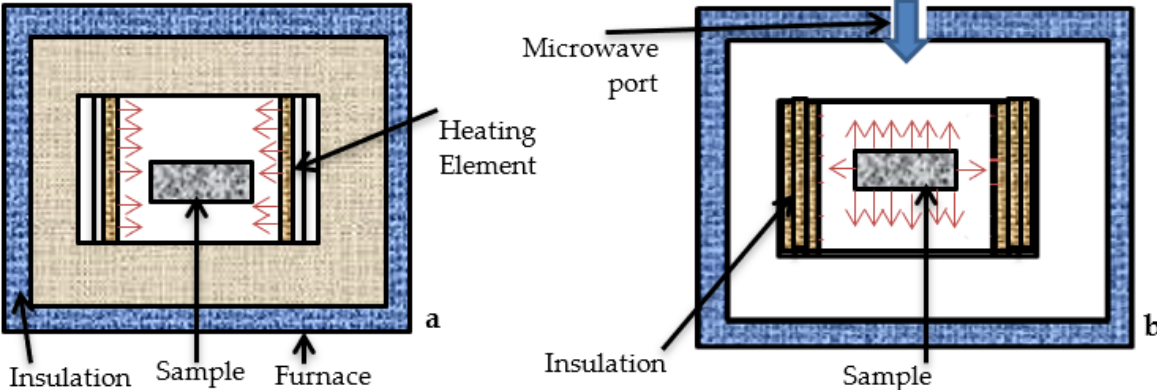
Figure 1. ( a ) Conventional sintering and ( b ) microwave sintering.